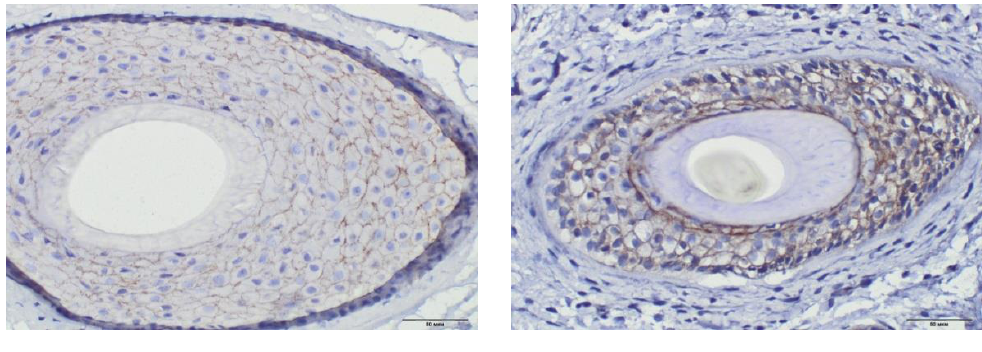
Figure 6. Area of β -catenin, magnification × 400. Figure 6. Area of β-catenin, magnification ×400. Figure 6. Area of β-catenin, magnification ×400.